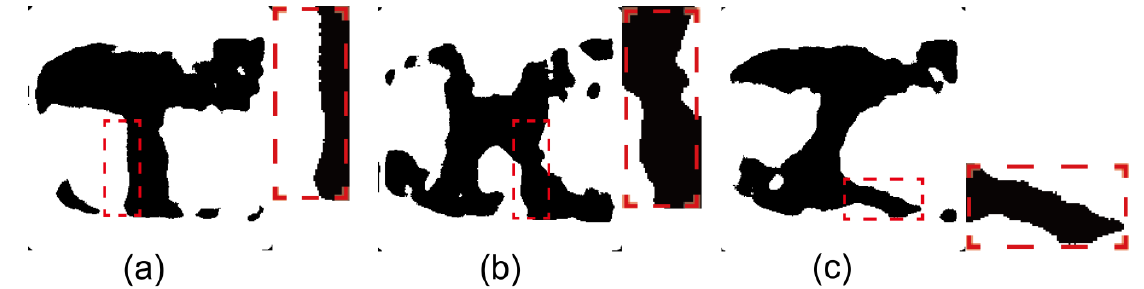
Figure 10. Corrected images of ( a ) sample 1, ( b ) sample 2, and ( c ) sample 3.